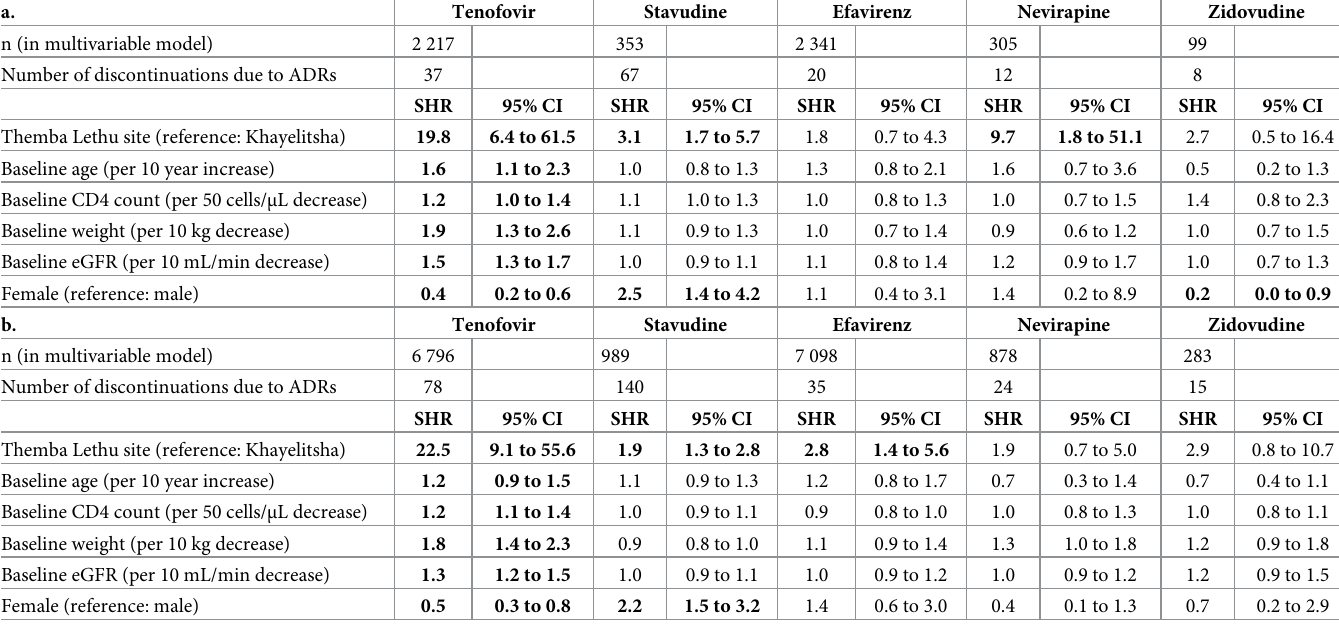
Table 2. Associations with discontinuations due to adverse drug reactions in a. enhanced-data patients (n = 3 837) and b. routine-data patients (n = 11 559) from two South African cohorts, who initiated antiretroviral treatment from